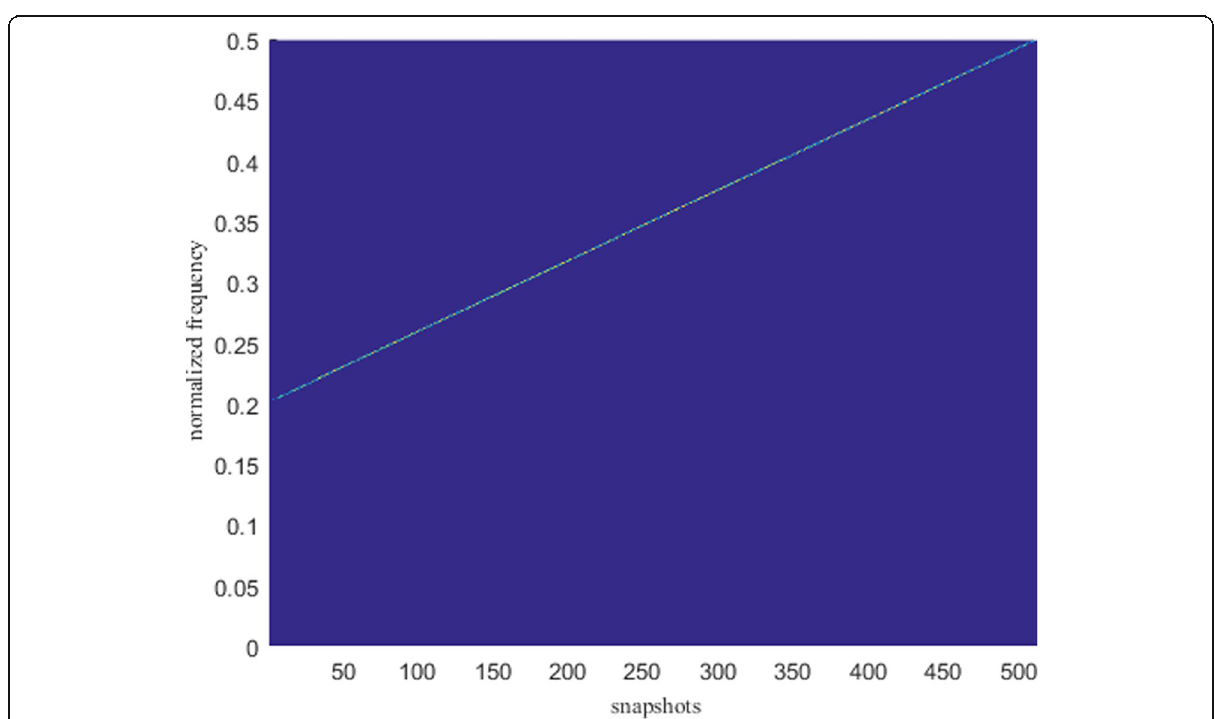
Fig. 5 Auto-terms of weak signal